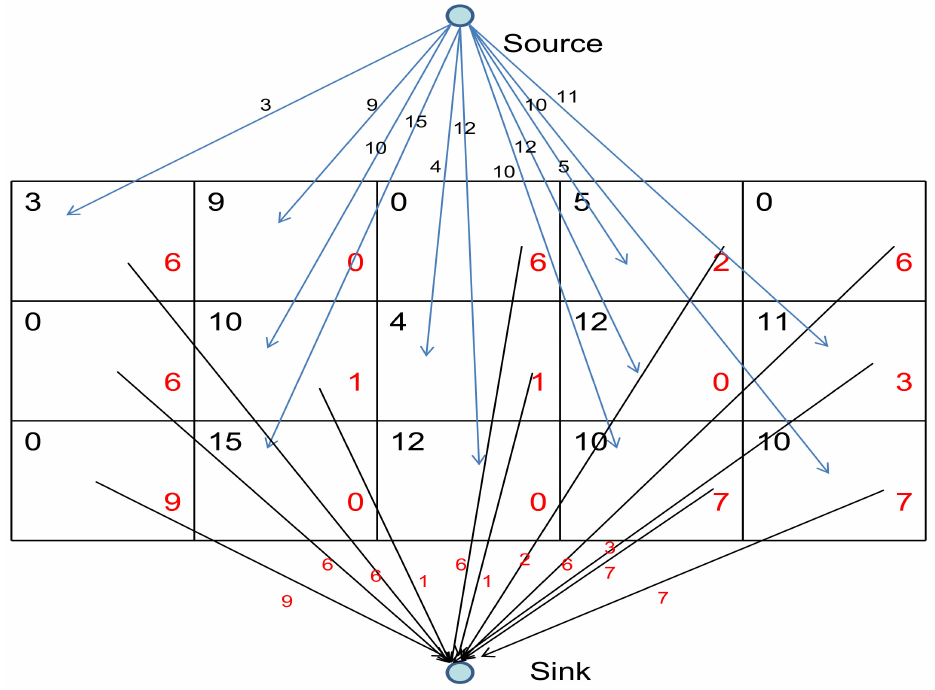
Figure 4. Three simulated models are combined to create new